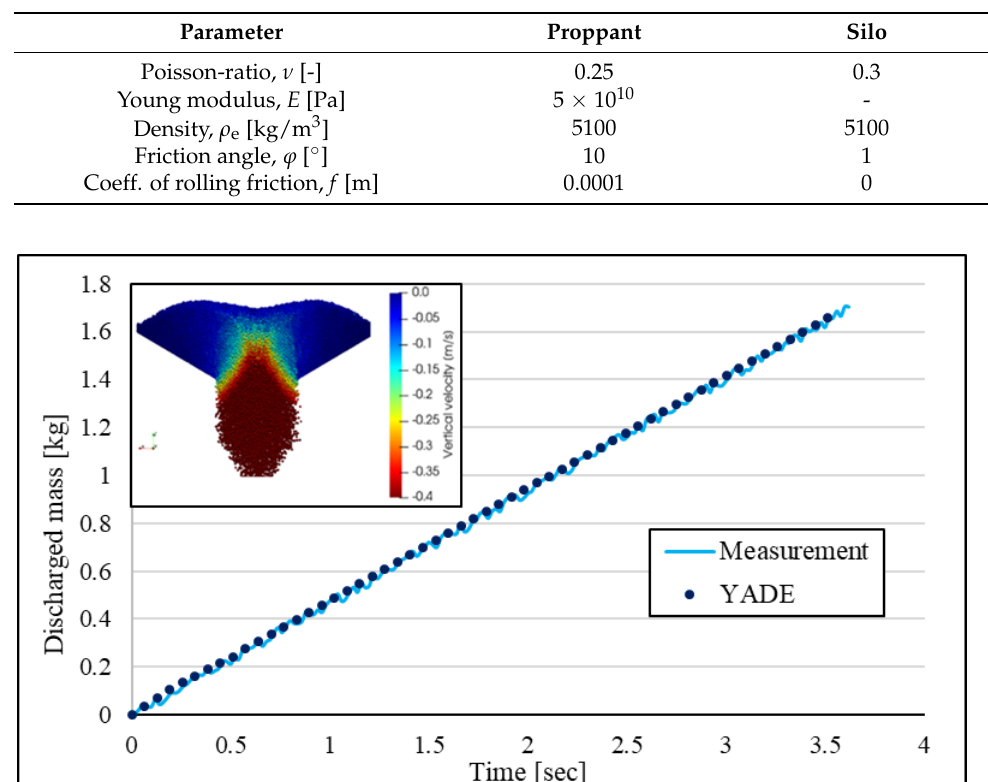
Table 1. Calibrated micromechanical parameters of proppant particles [40].